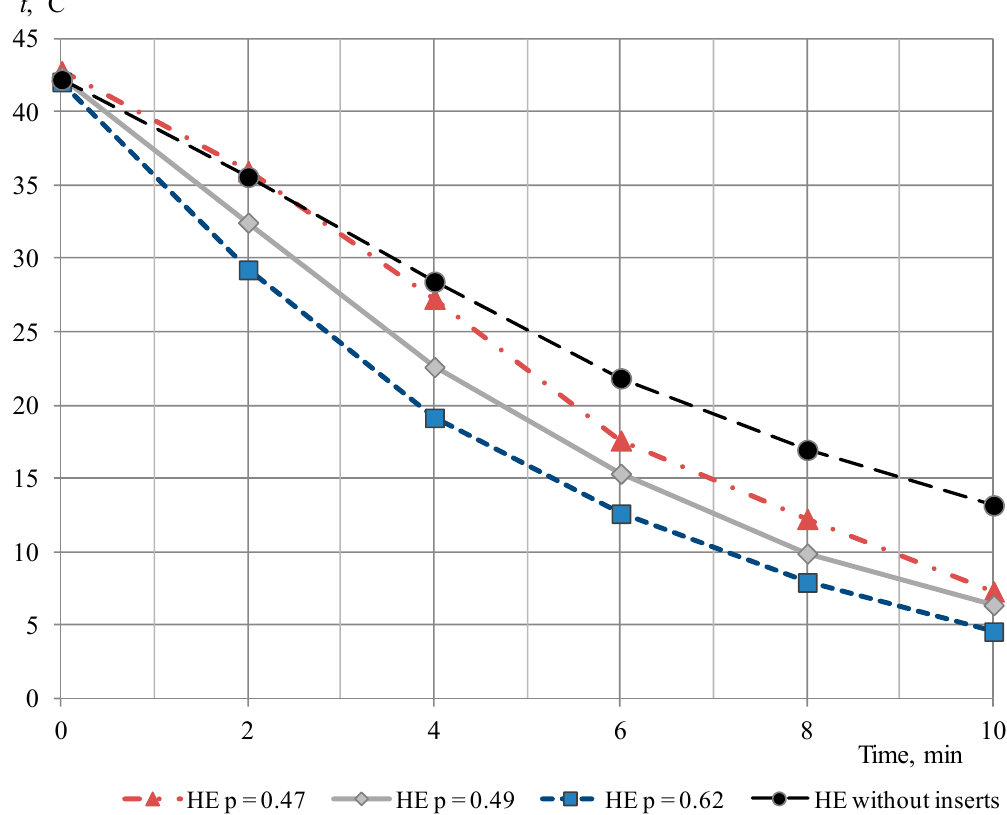
Figure 4. Change in water temperature over time when cooled by freon.